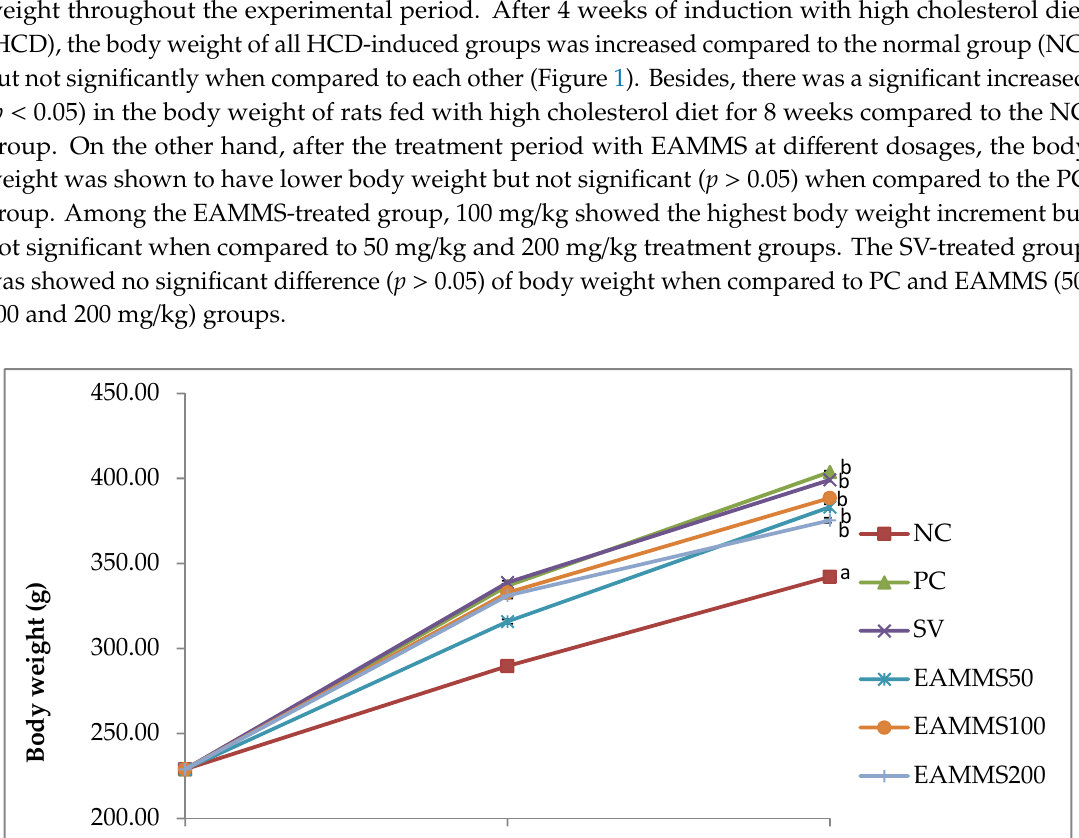
weight (right or left) between all groups.